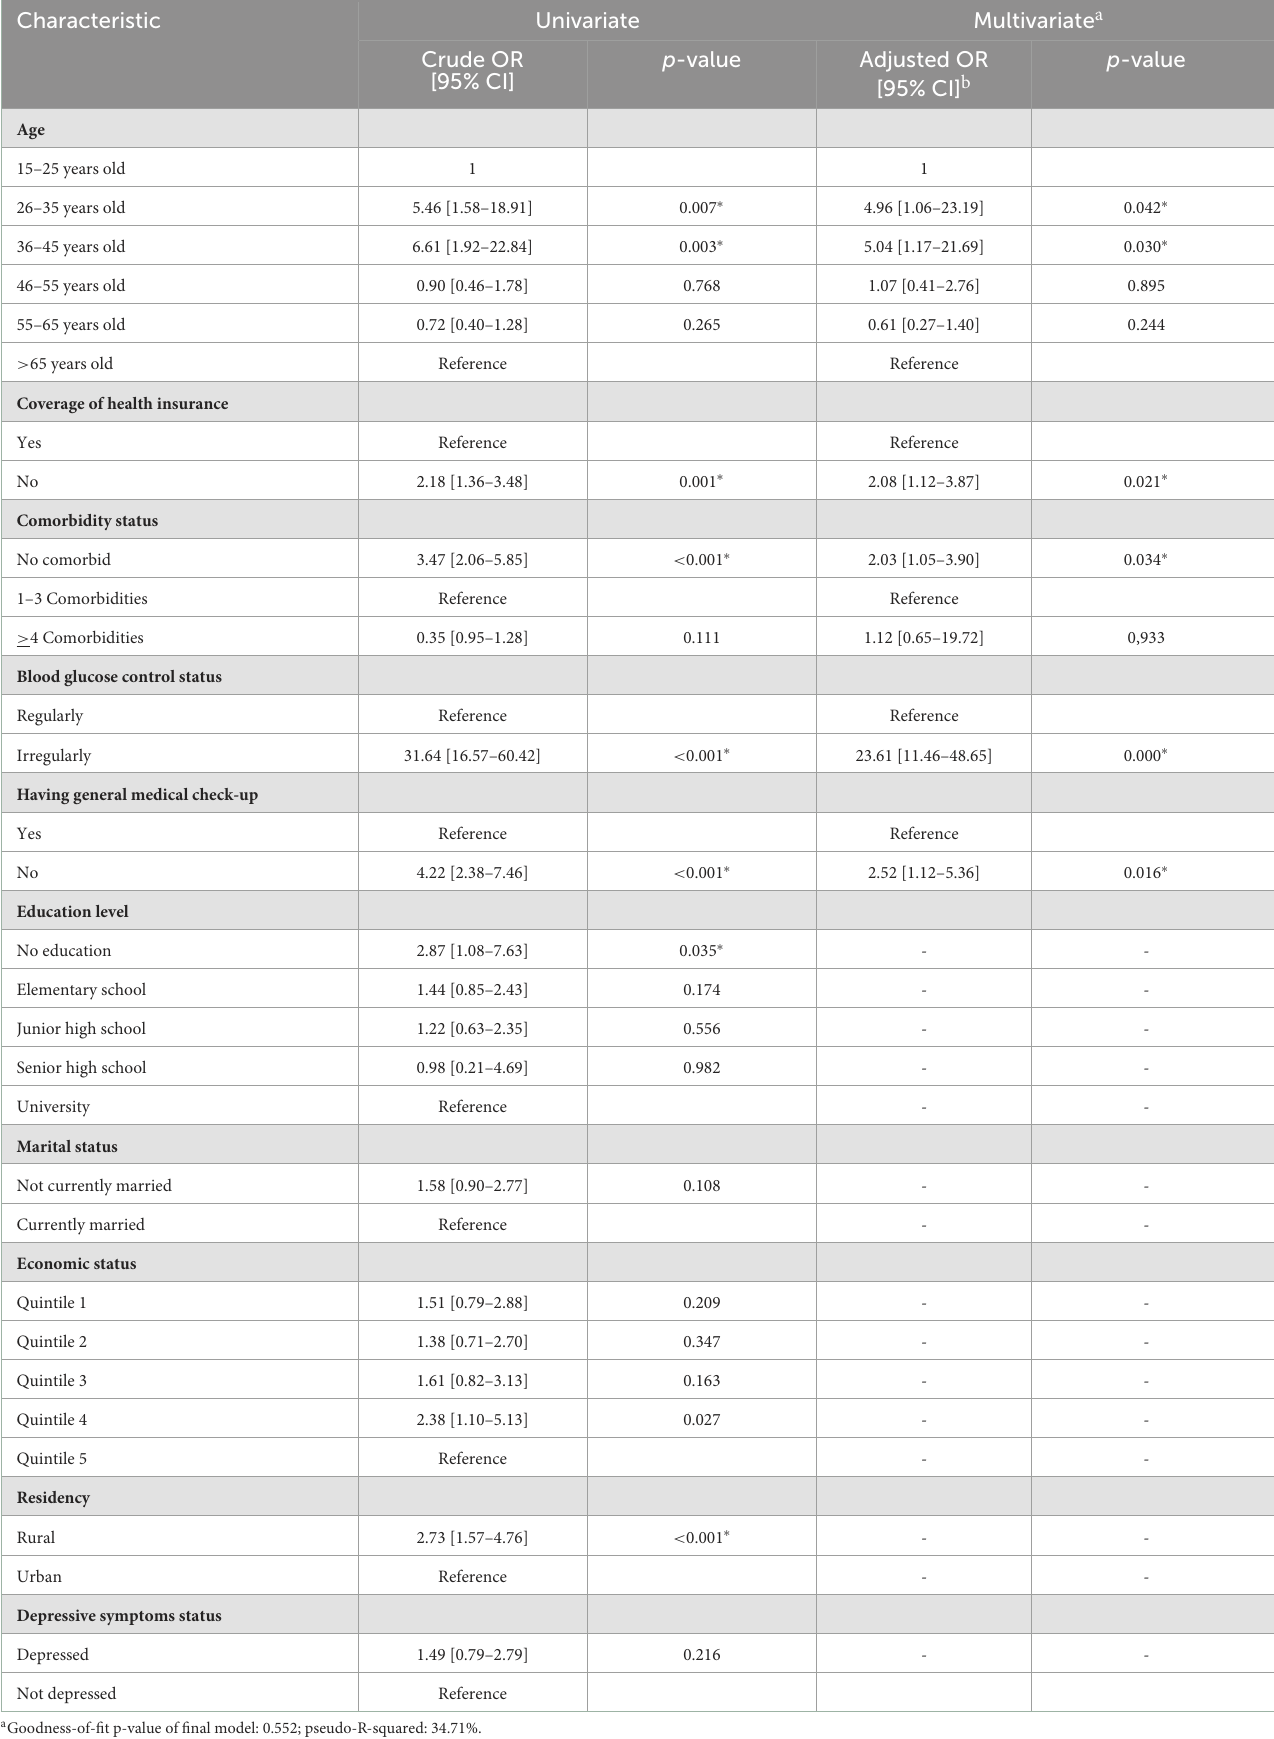
TABLE 2 Association between sociodemographic and behavioural factors and low awareness of diabetes mellitus medication. Characteristic Univariate Multivariate a Crude OR [95%